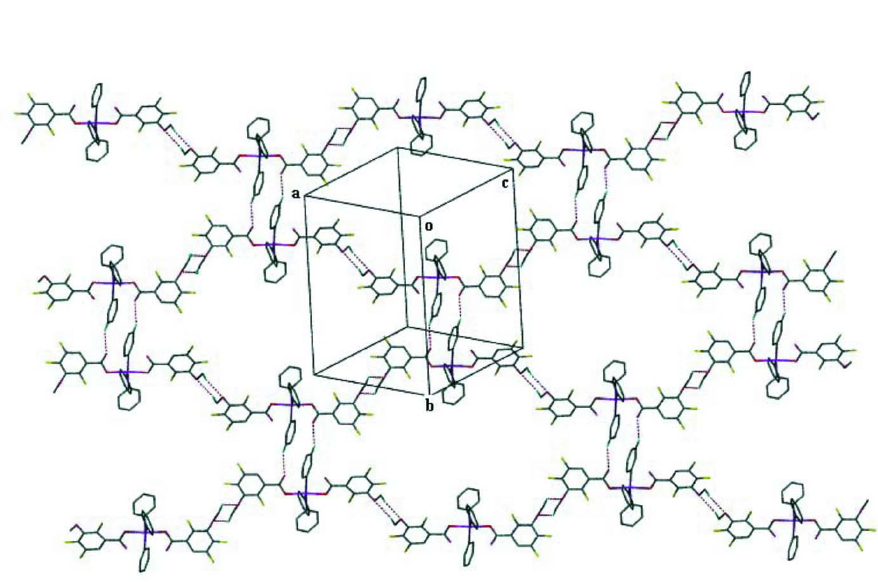
Figure 2 View of the two-dimensional layer structure in the title compound. Intermolecular hydrogen bonds are shown as dashed lines. H atoms are